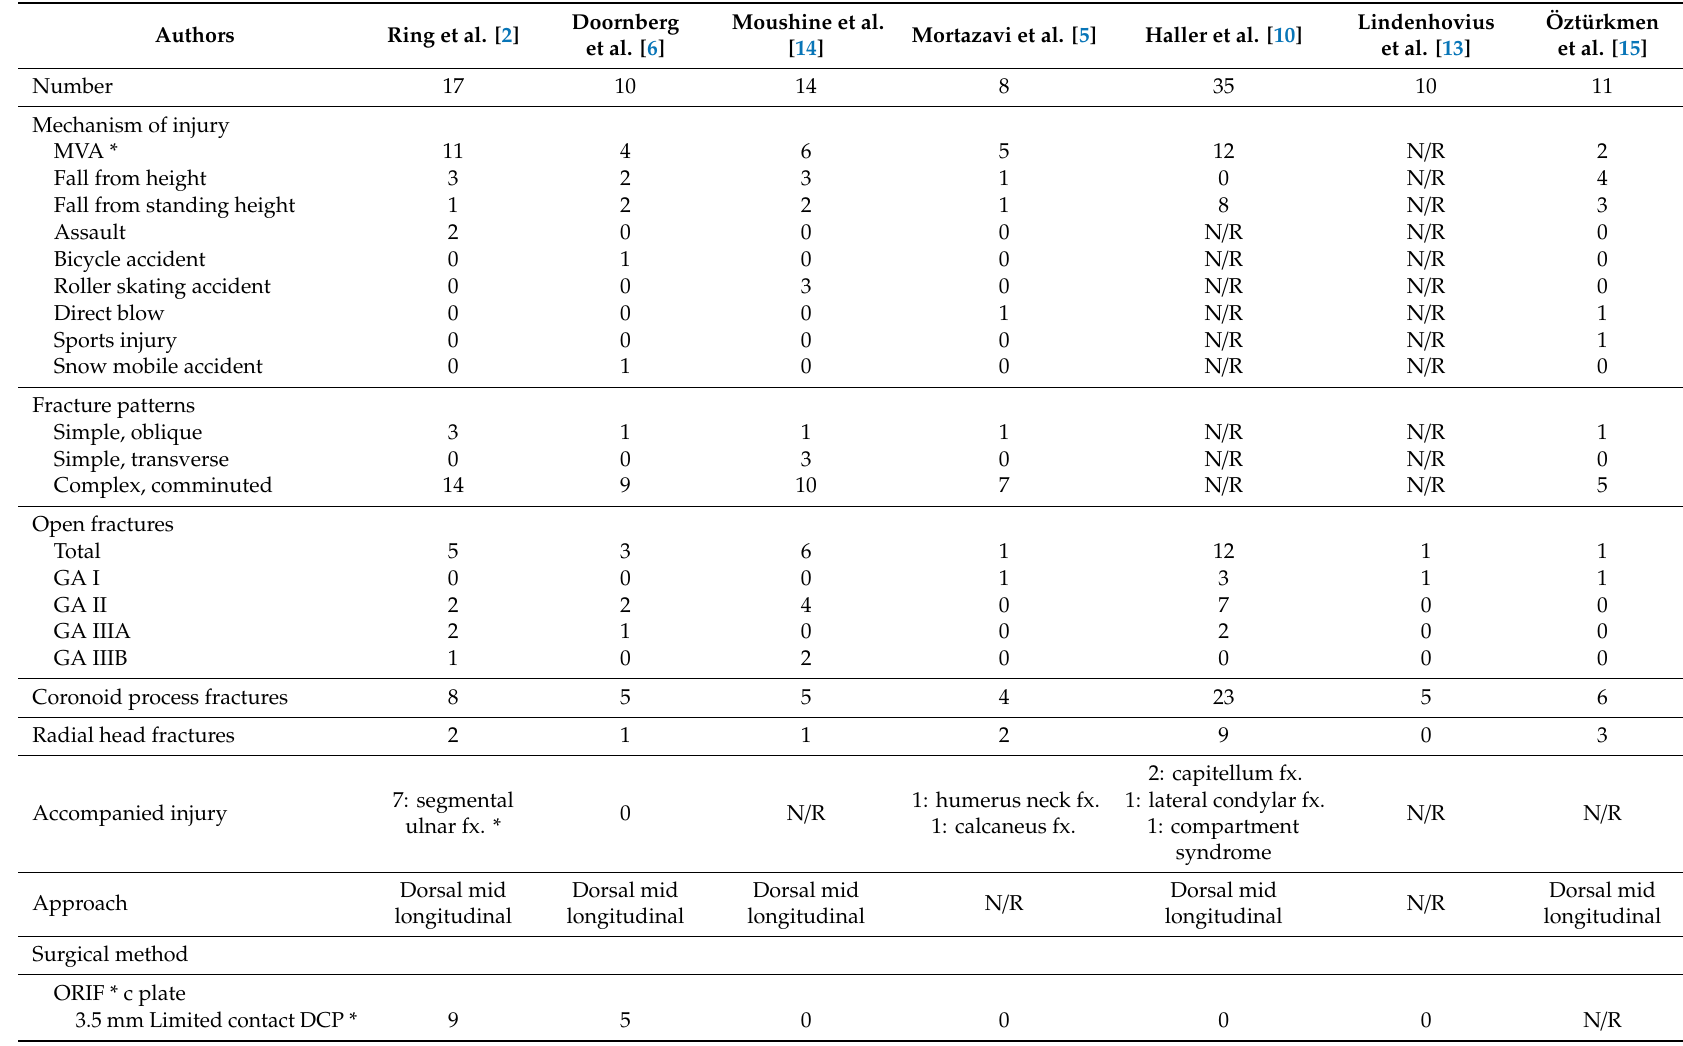
Table 2. Characteristic of fracture mechanism, treatment, and clinical score